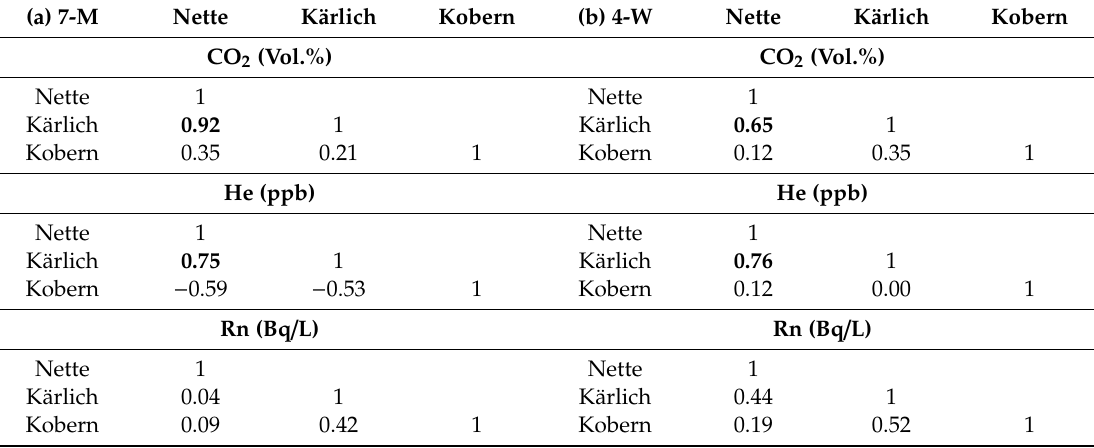
Table A1. Correlation coe ffi cients between fluctuation patterns of geogenic gas concentrations (centered and scaled data) during the bi-weekly ( a ) and 8-hourly ( b ) survey in the mineral springs. Significant correlation coe ffi cients [55] are highlighted in